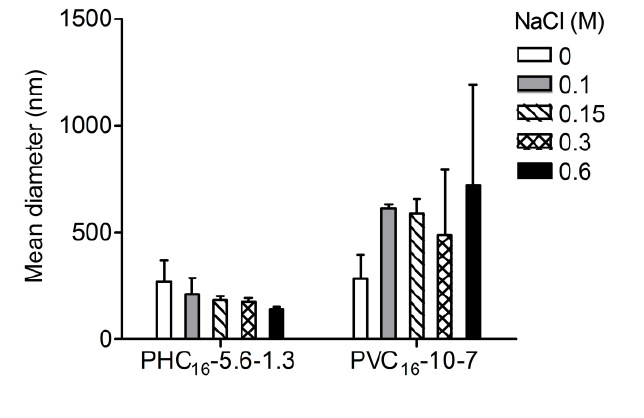
Figure 8. Influence of NaCl (0–0.6 M) on the size of pullulan-C measured at 37°C in DLS (mean ± S.D., n =